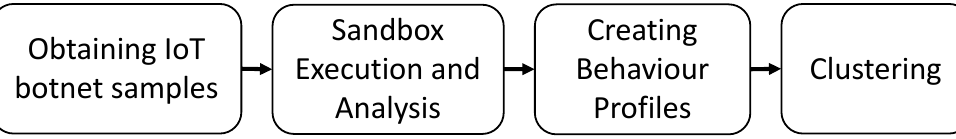
Figure 1. Steps comprising the proposed approach for automated behaviour-based clustering of IoT botnets.